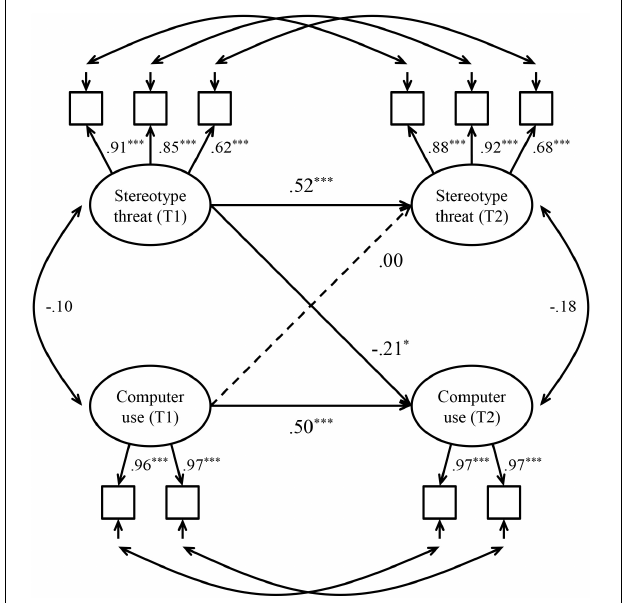
FIGURE 1 | Autoregressive cross-lagged panel model testing the relationship between stereotype threat and computer use. All path coefficients are standardized. Dotted lines indicate non-significant paths. Age, education, sex, living arrangements, occupational status, health status, and computer experience were included as covariates (omitted for clarity). T1 = Time 1, T2 = Time 2. * p < 0.05; *** p <